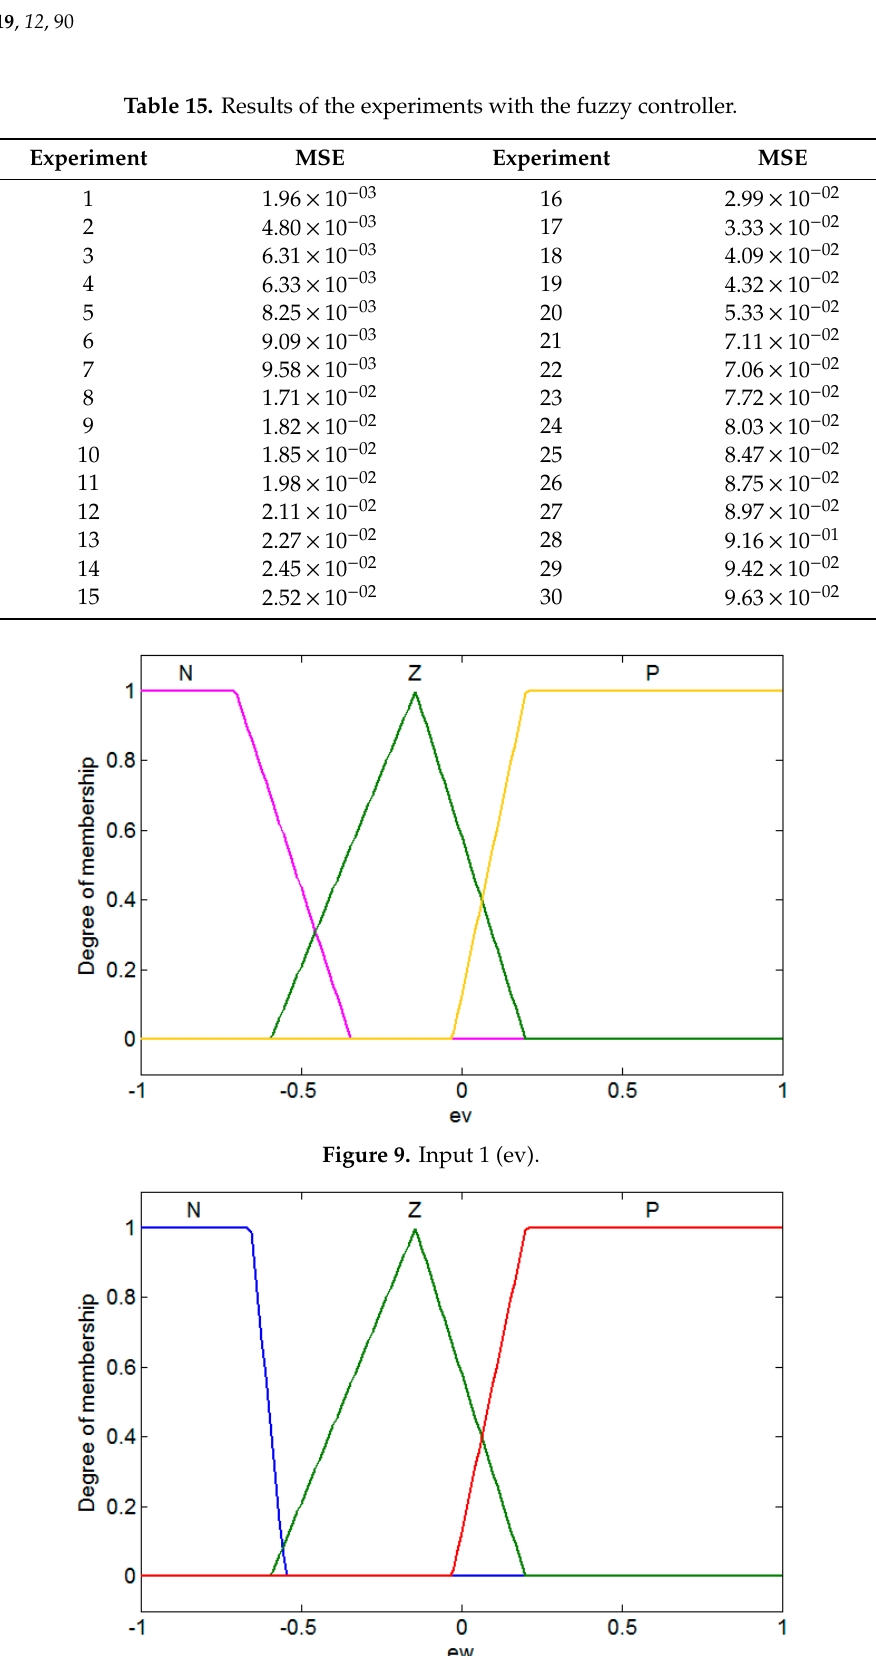
Figure 10. Input 2 Figure 10. Input 2 (ew). Figure 10. Input 2 (ew).